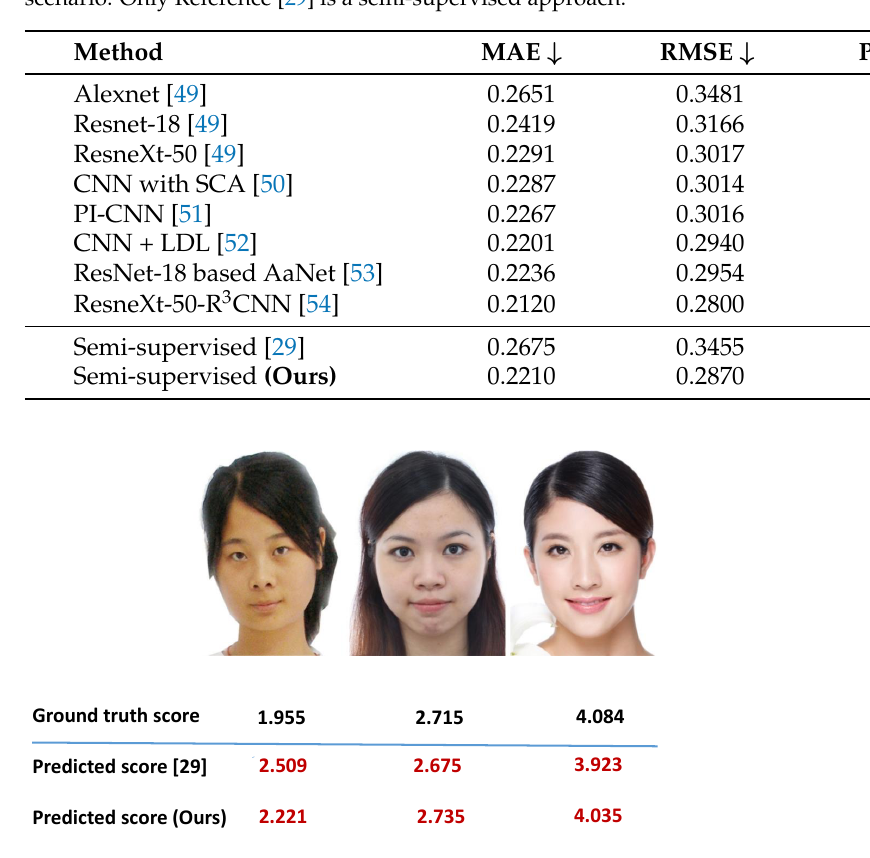
Table 4. Comparison with the state-of-the-art supervised methods using the five-fold cross-validation scenario. Only Reference [29] is a semi-supervised approach.